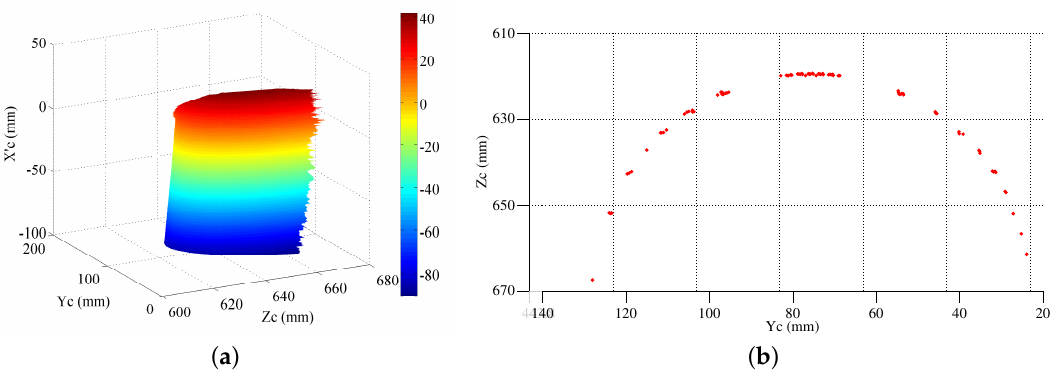
Figure 7. 3D measurement by the fringe projection vision system. ( a ) 3D point clouds in Matlab and ( b ) curve of the cross